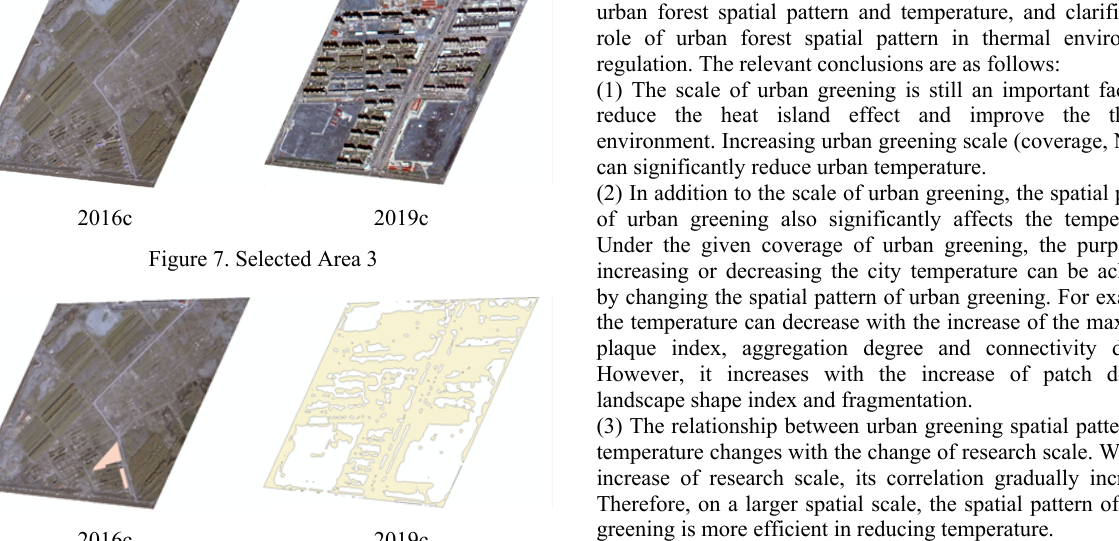
Figure 7. Selected Area 3